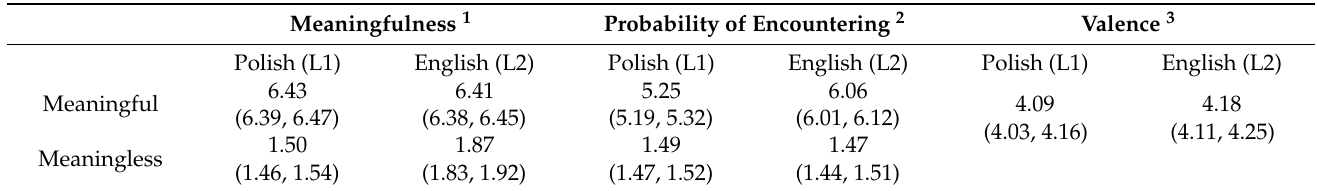
Table 5. Results of the norming study on the experimental sentences (means with 95%